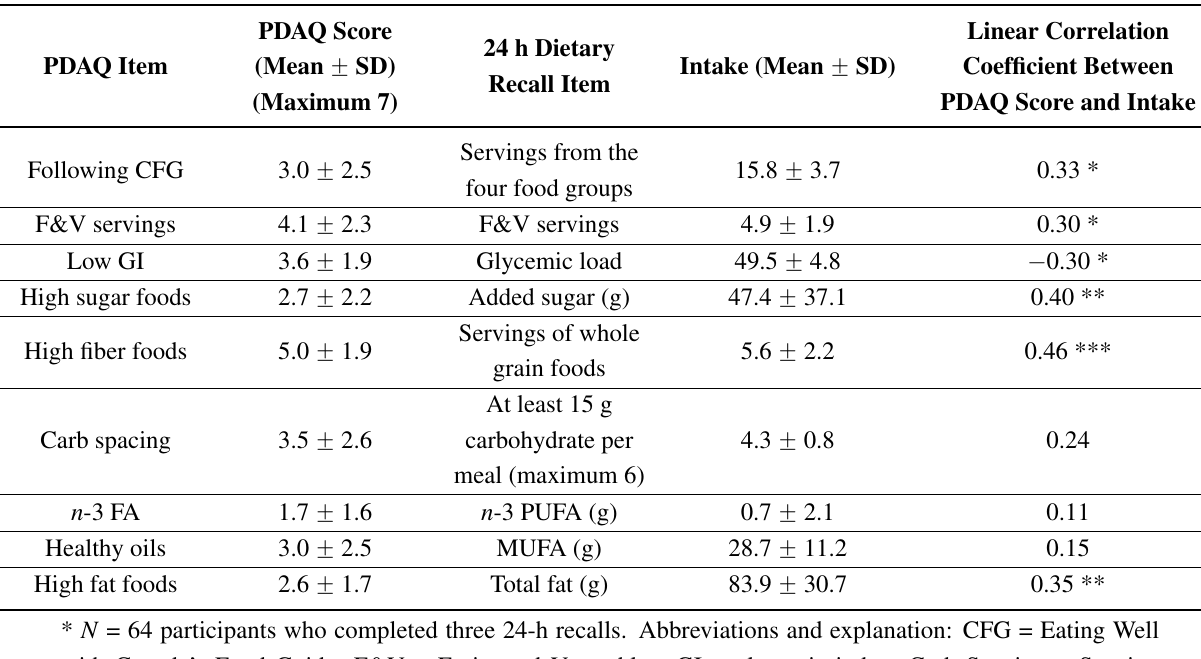
Table 3. Validity of Perceived Dietary Adherence Questionnaire (PDAQ) versus three 24-h dietary recalls *.